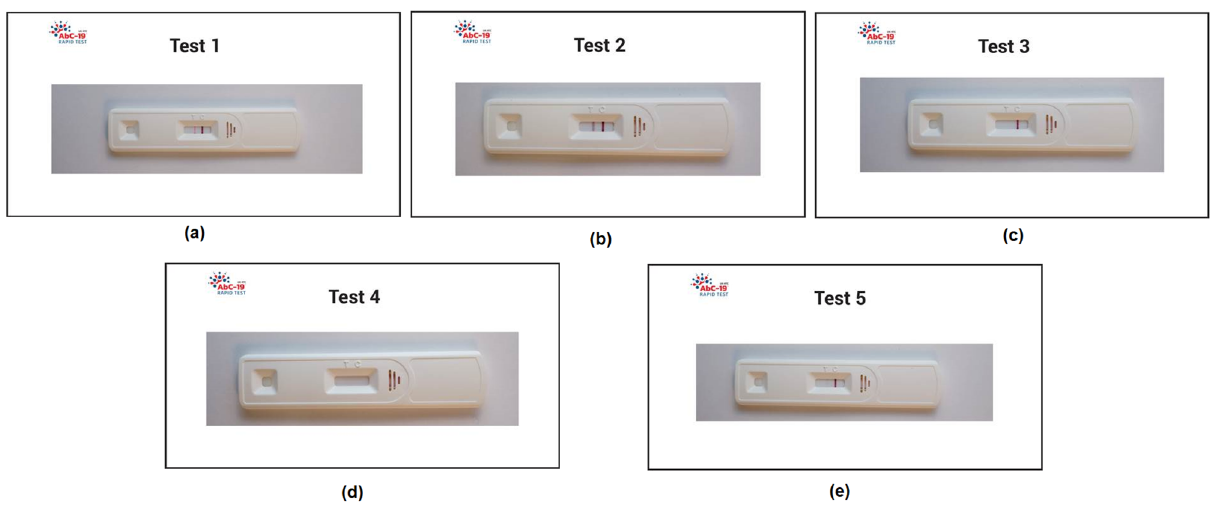
Figure 2. Examples of five printed test results that were designed for the study: ( a ) T1: positive; ( b ) T2: strong positive; ( c ) T3: negative; ( d ) T4: invalid, and ( e ) T5: weak